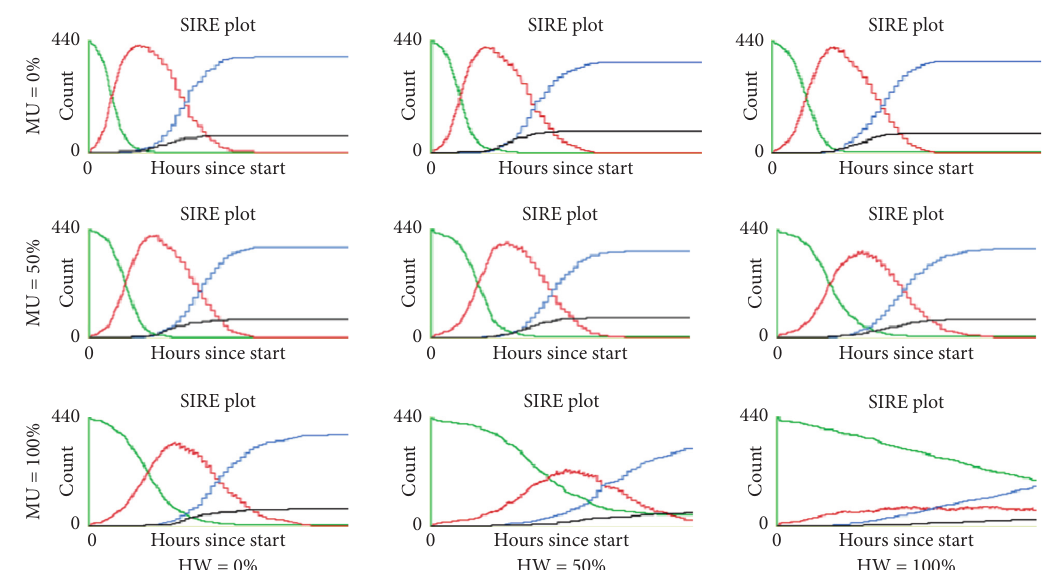
Figure 1: Representative SIRE curves for scenarios with SD � 0% and different combinations of MU and HW proportions (green, susceptible; red, infectious; blue, recovered; black, extinct).